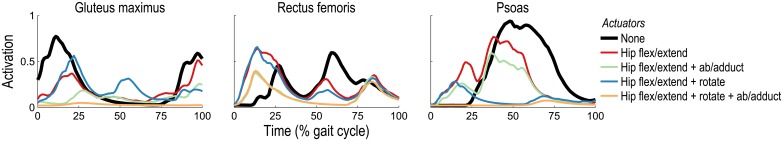
Activations of three representative muscles crossing the hip when running at 5 m/s with various hip assistive devices.Mean activations are shown for the gluteus maximus (left), rectus femoris (center), and psoas (right) on the right leg when running without assistance (black) and with four combinations of three hip actuators: flexion/extension only (red), flexion/extension with abduction/adduction (green), flexion/extension with internal/external rotation (blue), and all three actuators (orange). These results suggest that the gluteus maximus is particularly effective at generating a hip abduction moment because its activation decreased dramatically when the abduction/adduction actuator was added (e.g., compare the blue and orange curves). The rectus femoris does not appear to be especially favorable for generating a hip rotation moment because its activation was similar regardless of whether the internal/external rotation actuator was present (i.e., the red and blue curves are approximately equal, as are the green and orange curves).